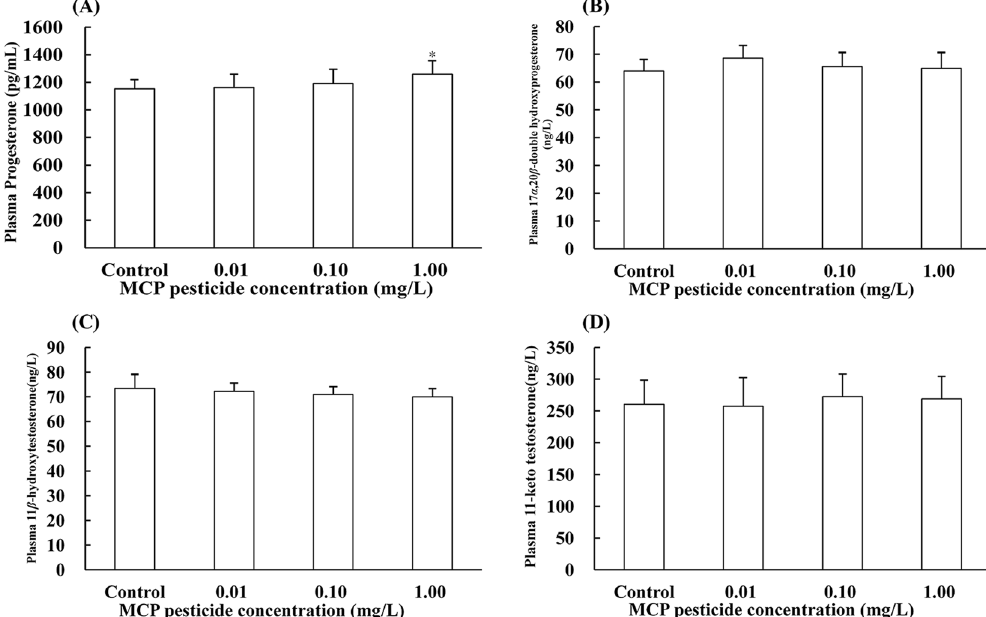
Figure 5. Effects of MCP pesticide on plasma content of effectual hormones in male goldfish ( Carassius auratus ).